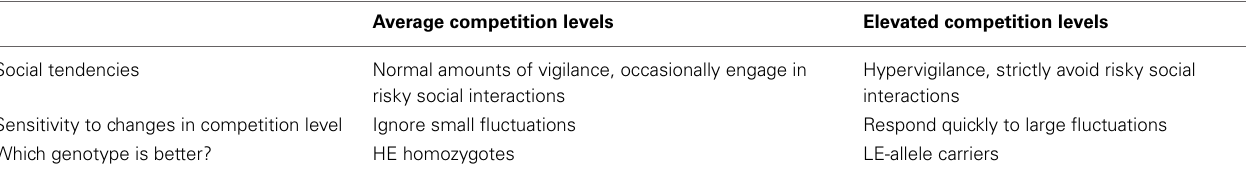
Table 2 | Behavioral “best practices” in primates with fluctuating levels of within-group competition over